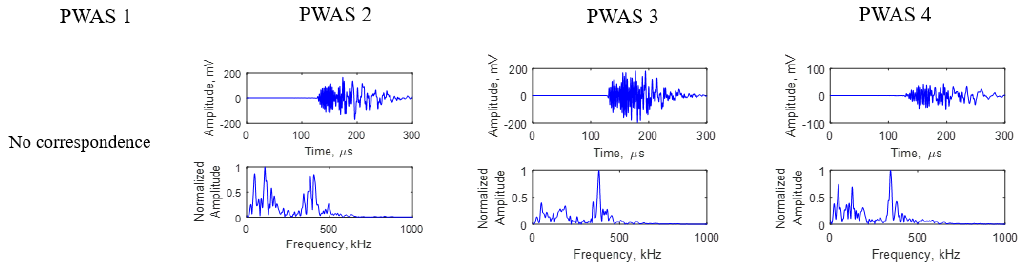
Figure 13. Signal correspondence at all four PWAS due to a hit corresponding to damage formation.